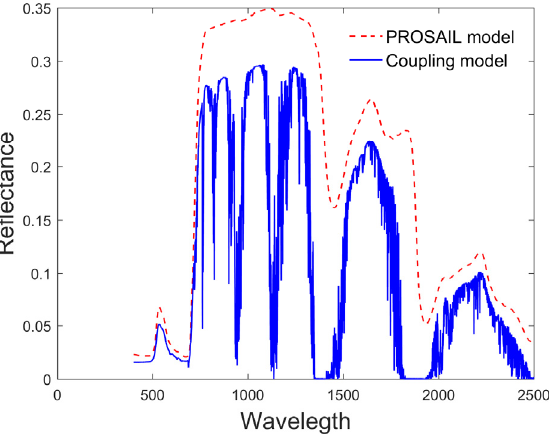
Figure 3. The spectral reflectance simulated by PROSAIL and the coupling model.